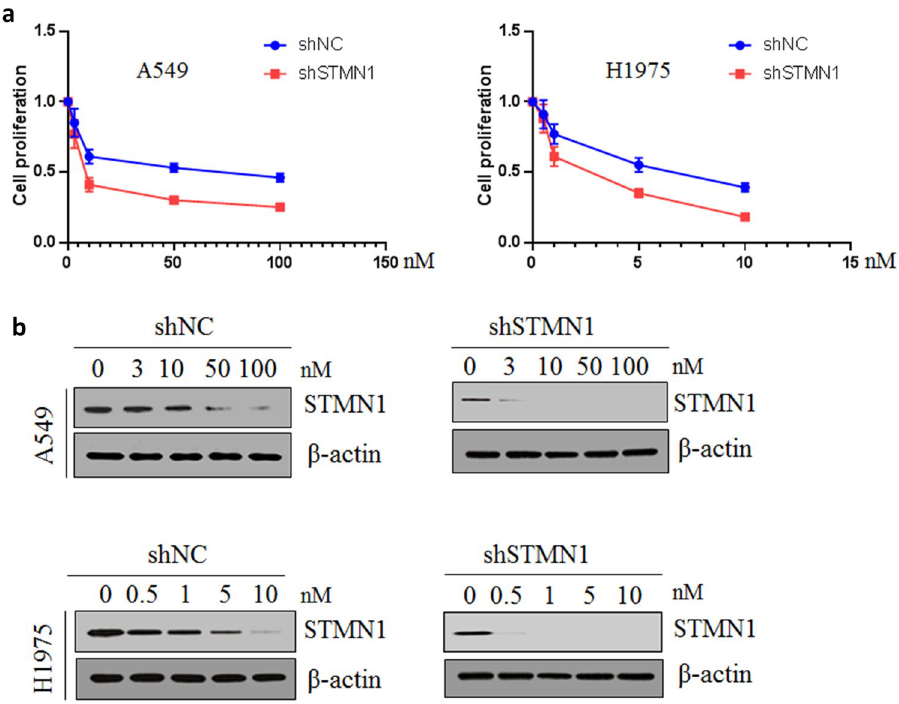
Figure 3. Knockdown of STMN1 led to the sensitivity to paclitaxel. ( a ) Lung cancer cell A549 and H1975 was treated with different concentration of paclitaxel, and cell proliferation was evaluated after knockdown of STMN1 in lung cancer cells. ( b ) Western blotting was used to detect the expression of STMN1 after lung cancer cell A549 and H1975 was treated with different concentration of paclitaxel. Full-length images are presented in Supplementary Fig.